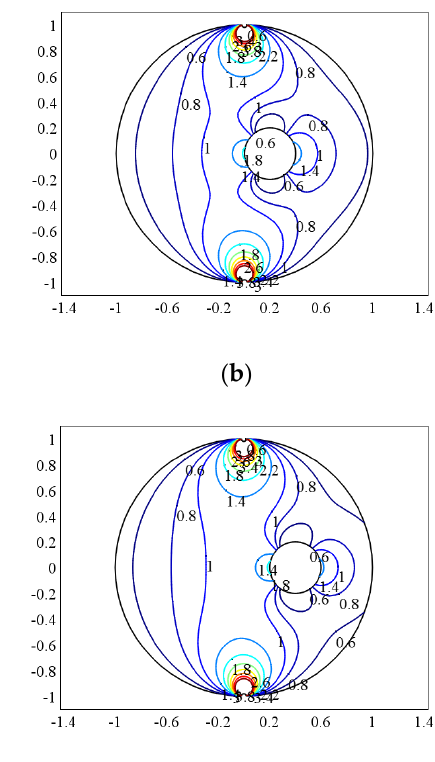
weight function near the other electrode changes more and more gently, indicating that the presence